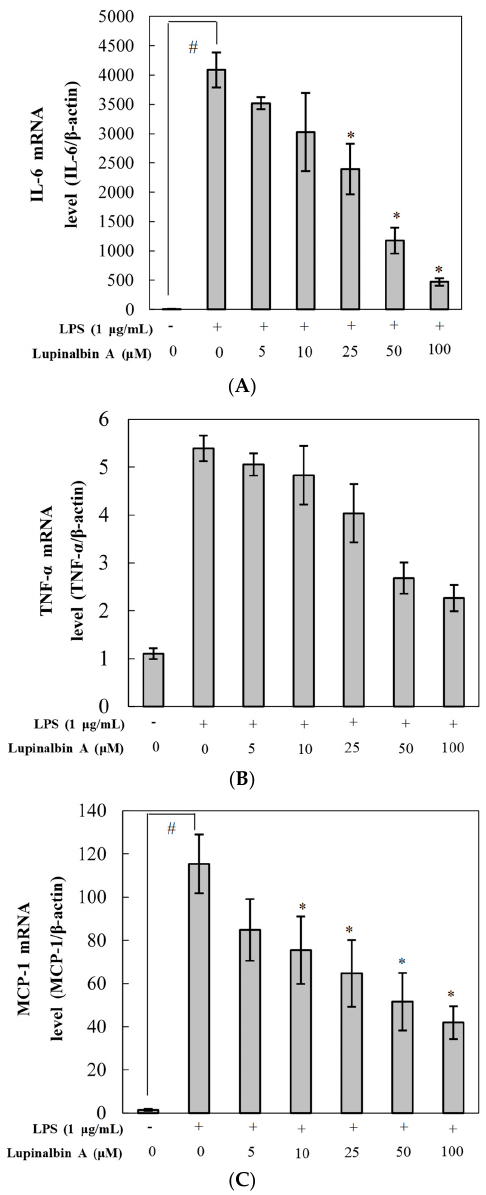
Figure 4. Effect of lupinalbin A on ( A ) IL-6; ( B ) TNF- α ; and ( C ) MCP-1 mRNA expression in LPS-treated RAW264.7 cells. Cells were treated with various concentrations of lupinalbin A (5–100 µM) for 2 h and then stimulated with LPS (1 µg/mL) for 18 h. IL-6, TNF- α , and MCP-1 mRNA expression levels were determined by qRT-PCR. The data are presented as mean ± SDs ( n = 3). # p < 0.05 vs. control group, * p < 0.05 vs. LPS-treated group.